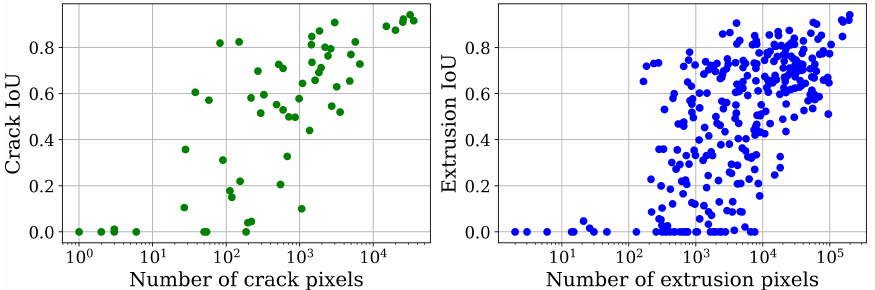
Figure 6. Tile image-wise IoU metric shown as a function of contained crack and extrusion pixels,